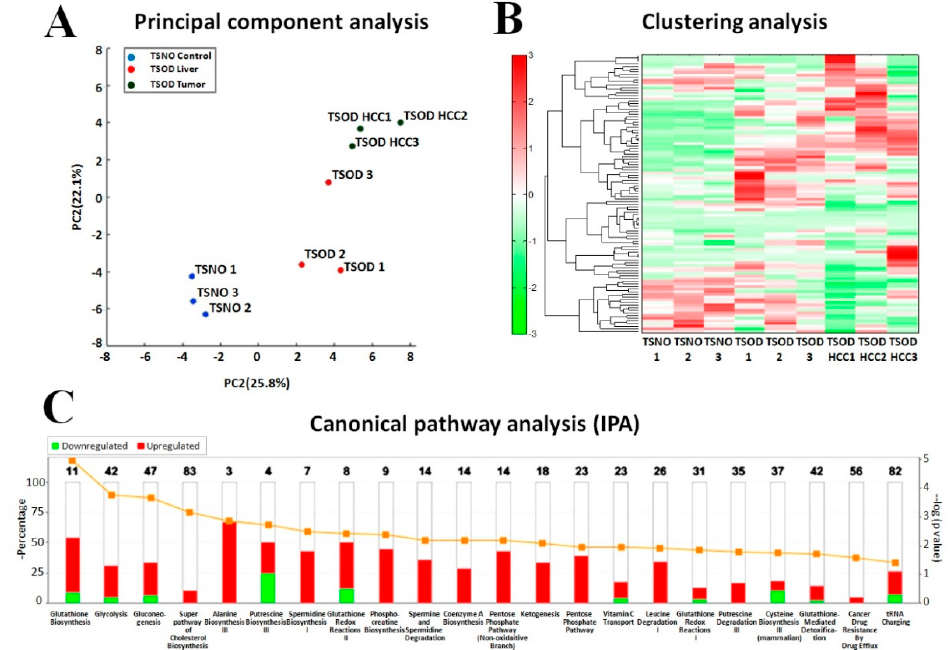
Figure 2. Alterations detected by the metabolome and IPA analyses in the livers and tumors of TSOD mice. Principal component analysis ( A ), clustering ( B ), and canonical pathways ( C ) analyses.